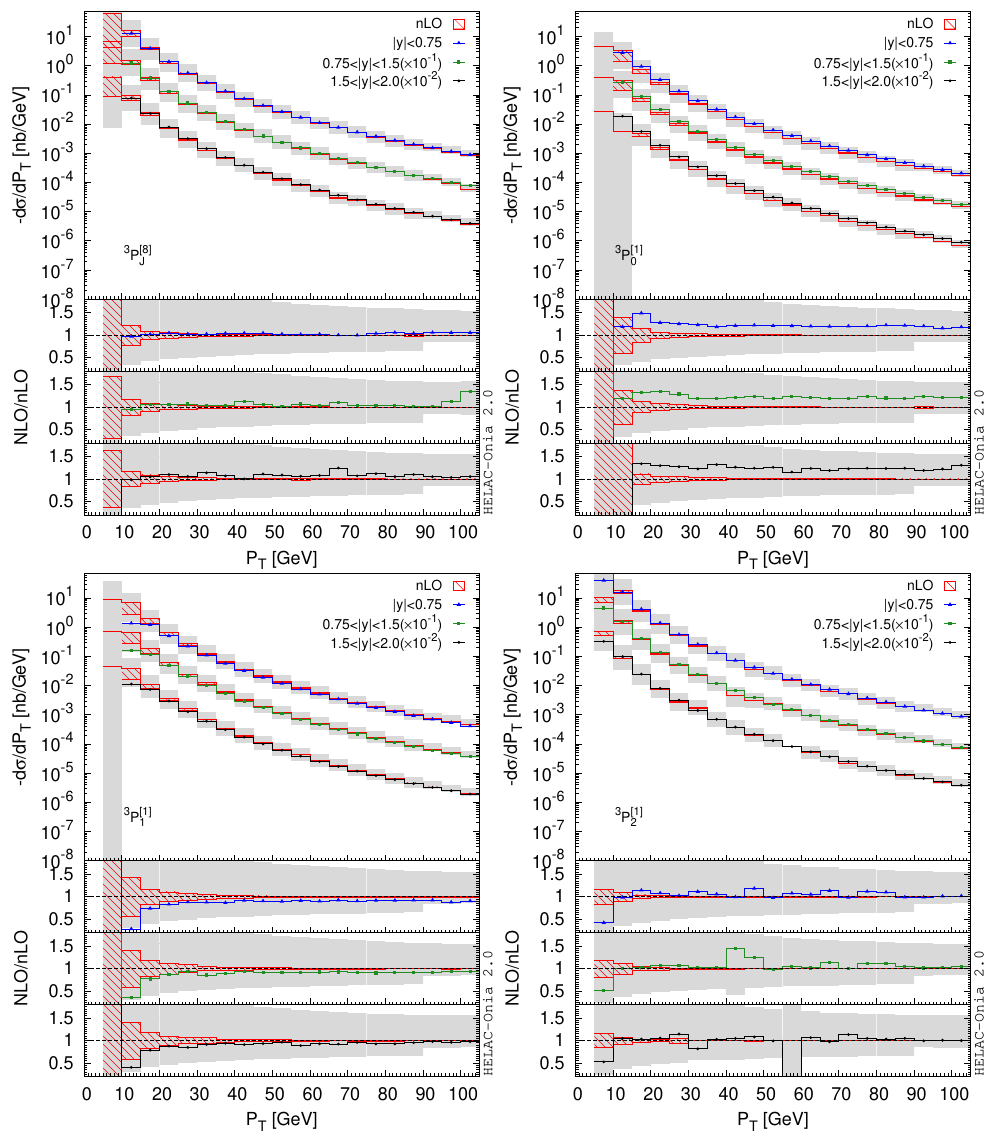
Figure 21 . Comparisons of spin-summed differential cross sections for the Fock states 3 P [8] 3 P [1] , 3 P [1] between our nLO calculations and the complete NLO calculations. They are similar to 1 2 figure